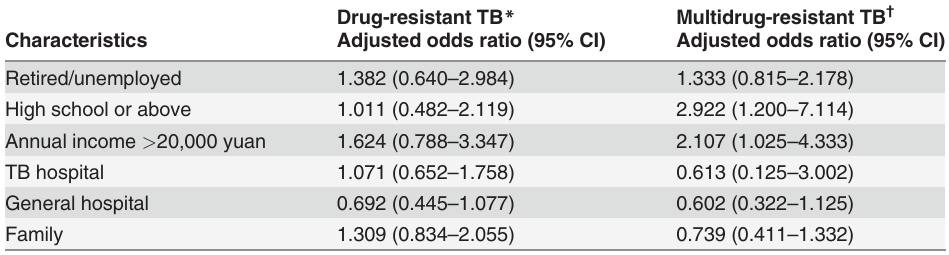
Table 3. Multivariate analysis of risk factors for drug-resistant tuberculosis (TB) in re-treated TB